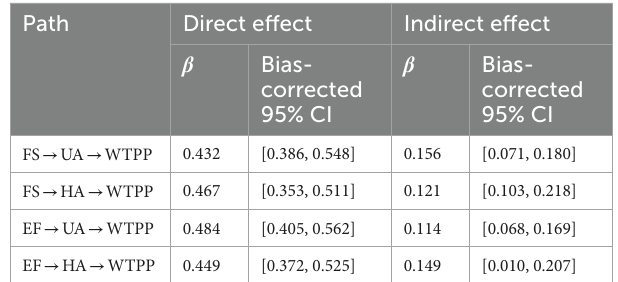
TABLE 6 Results of mediation analysis.